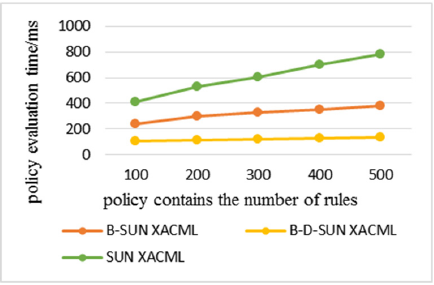
Figure 6. Policy evaluation time varies with the number of rules.